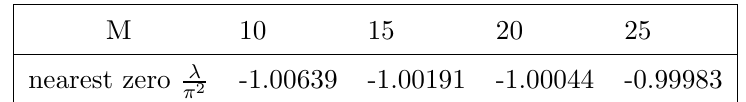
Table 2 . Smallest singularities of (cid:1) (cid:13) 3 =(cid:21) 3 as determined from its diagonal Pad(cid:19)e [ M=M ] approxi- mants. See the text for more